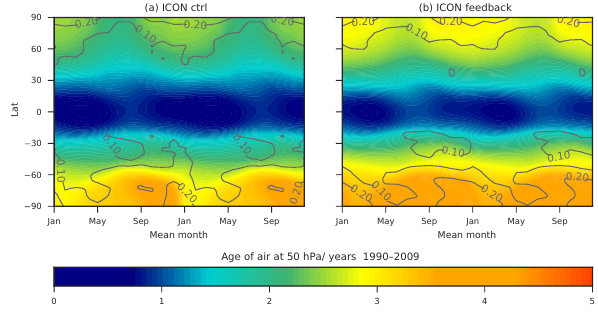
Figure 15. Monthly averaged zonal means of age of air (year) at 50hPa (shown twice) for the period from 1990 to 2009 (shaded). Contour lines represent the standard deviation of the monthly means. (a) Control run; (b) feedback